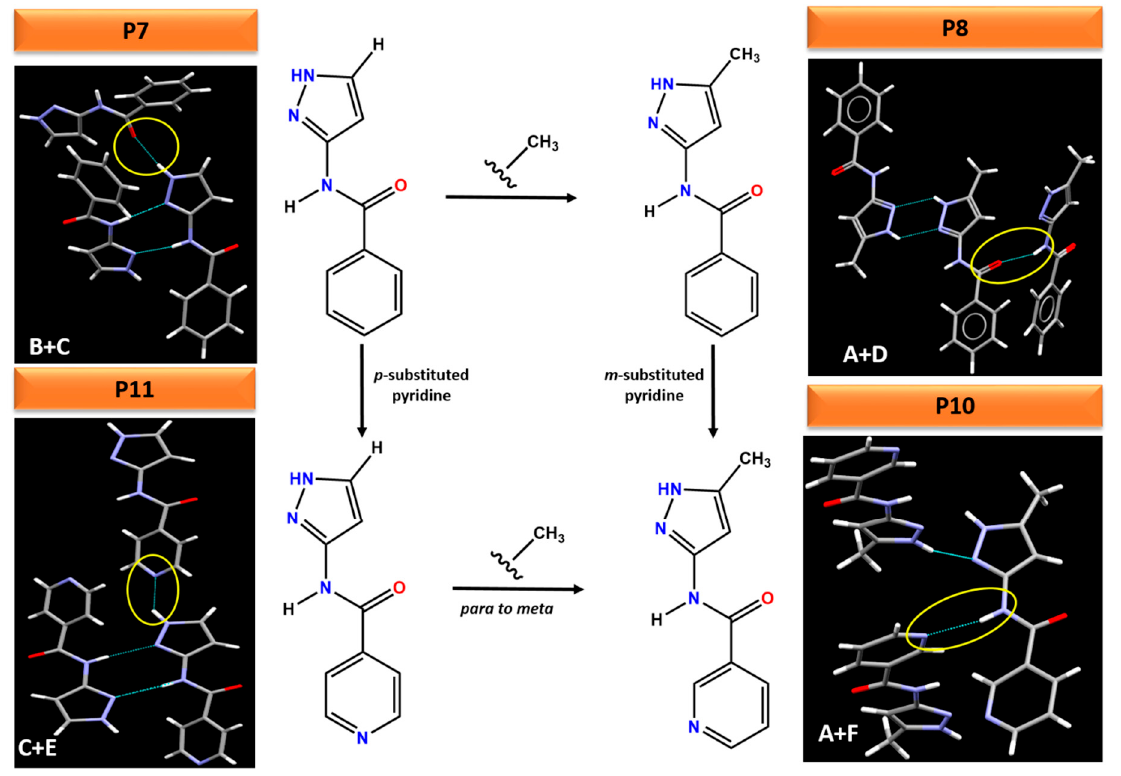
Figure 12. Comparison of subtle variations on the molecular fragments leading to different hydrogen bonding interactions in crystal structures of P7 , P8 , P10 and P11 .